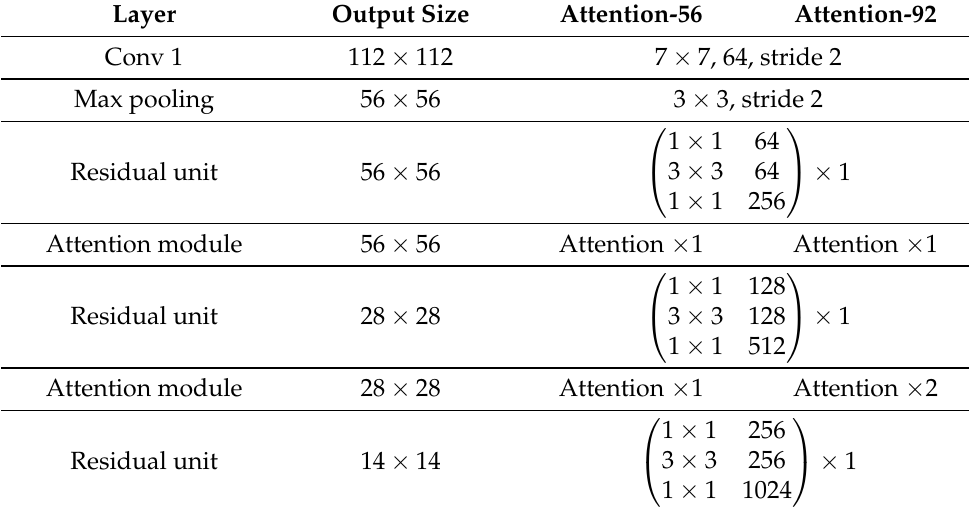
Table 2. Network configuration of Attention-56 and Attention-92